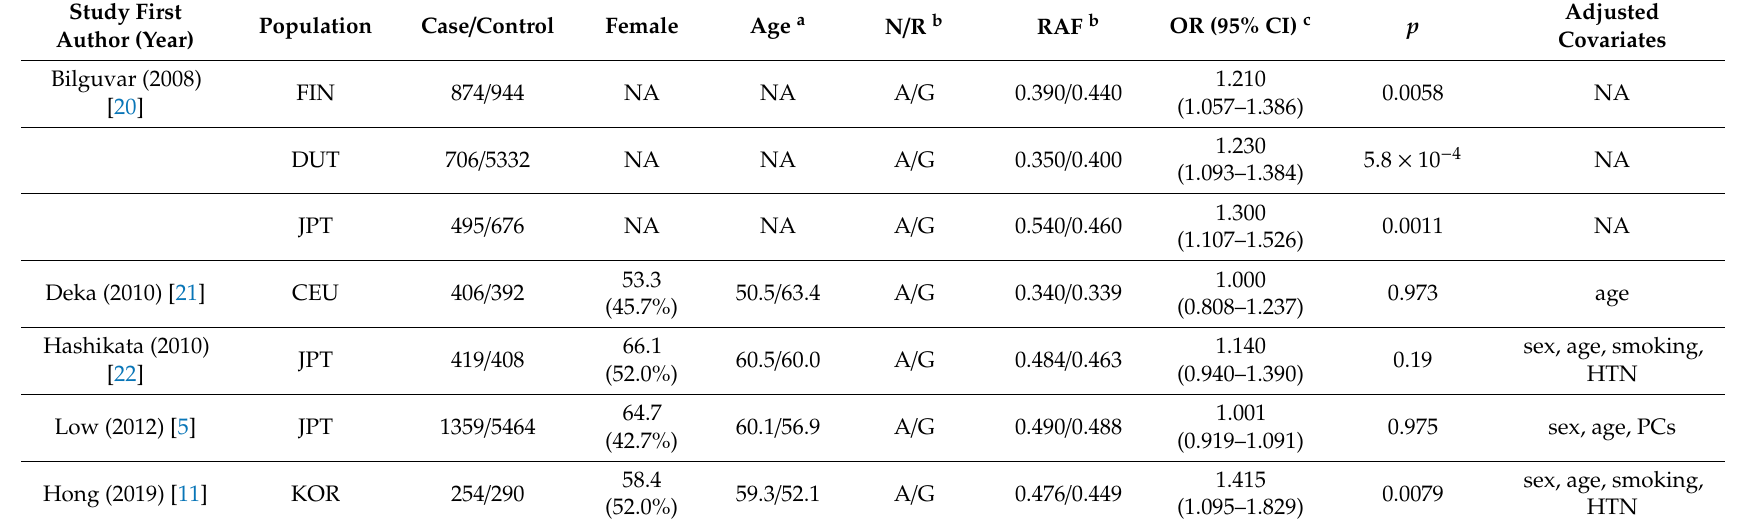
Table 1. Study characteristics of the rs700651 variant in multi-ethnic